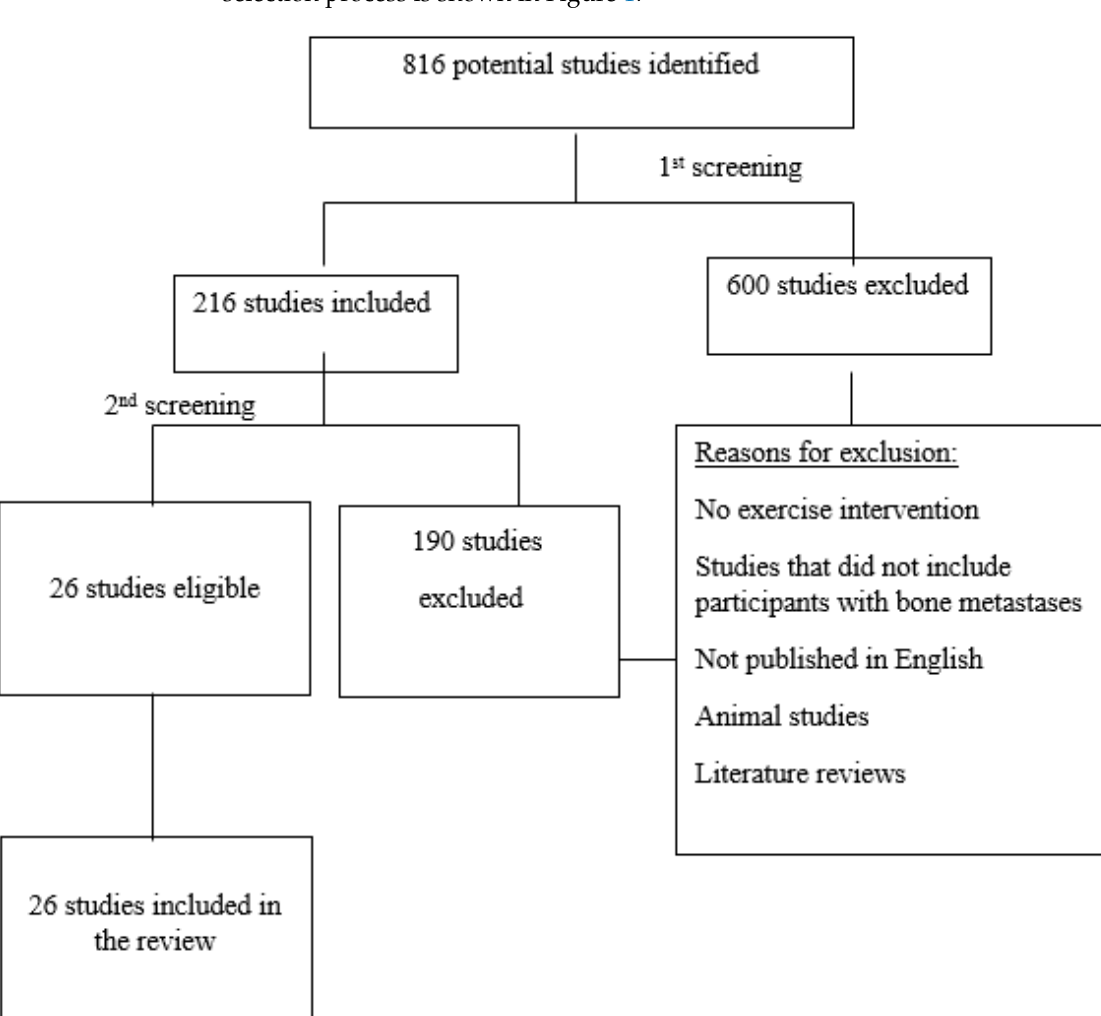
Figure 1. Workflow and selection process for document inclusion in the scoping review.